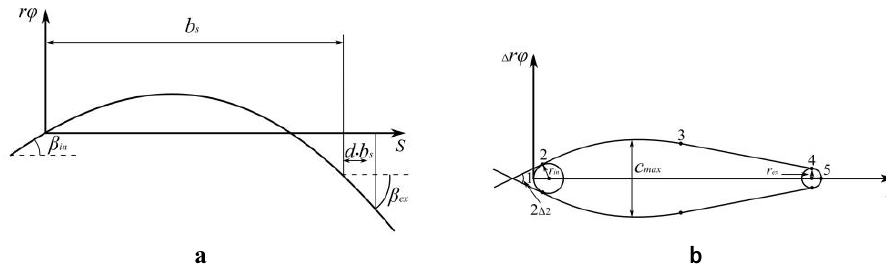
а b Figure 4. Blade section: а − blade mean line; Figure 4: Blade section: a - blade mean line; b - blade thickness with respect to the mean line Table 1: Basic geometric dimensions of the flow part